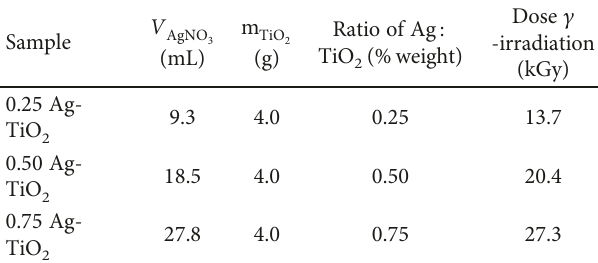
Table 1: Preparation of Ag-TiO